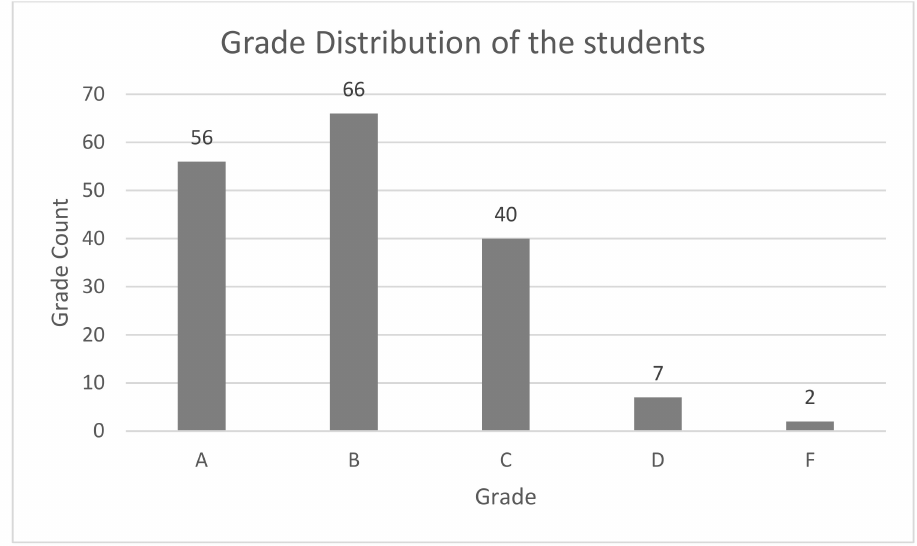
Figure 5. Grade distribution of